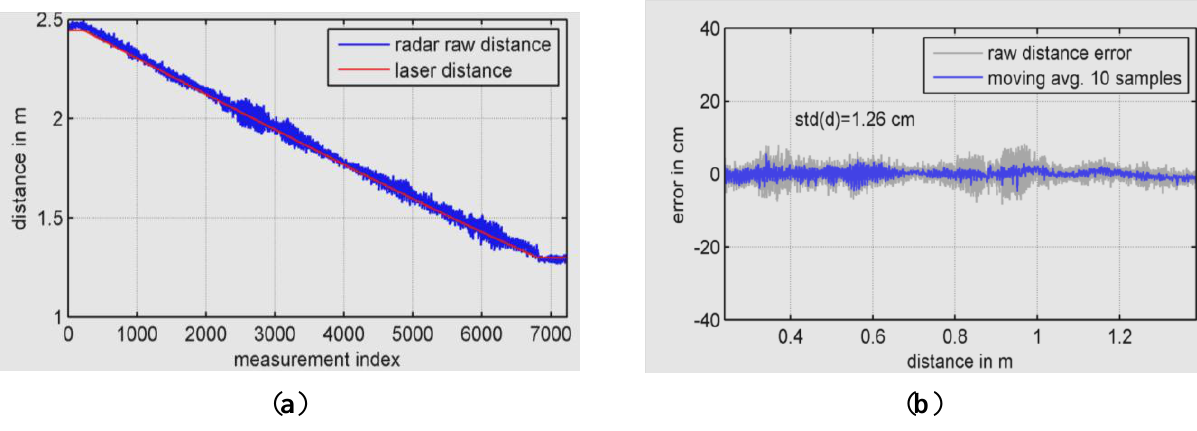
Figure 9. ( a ) Distance compared to laser distance. ( b ) Measurement error within 1 m.